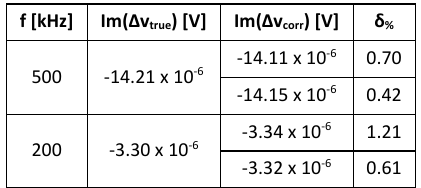
Table 9: Accuracy of the corrected signals Im(Δv corr ) with respect to the true signals Im(Δv true ) . Im(Δv corr ) and Im(Δv true ) are taken from tables (5, 7), respectively, where in case of Im(Δv corr ) there are two values per frequency because the original error detection measurements were conducted with an active and a passive marker at each